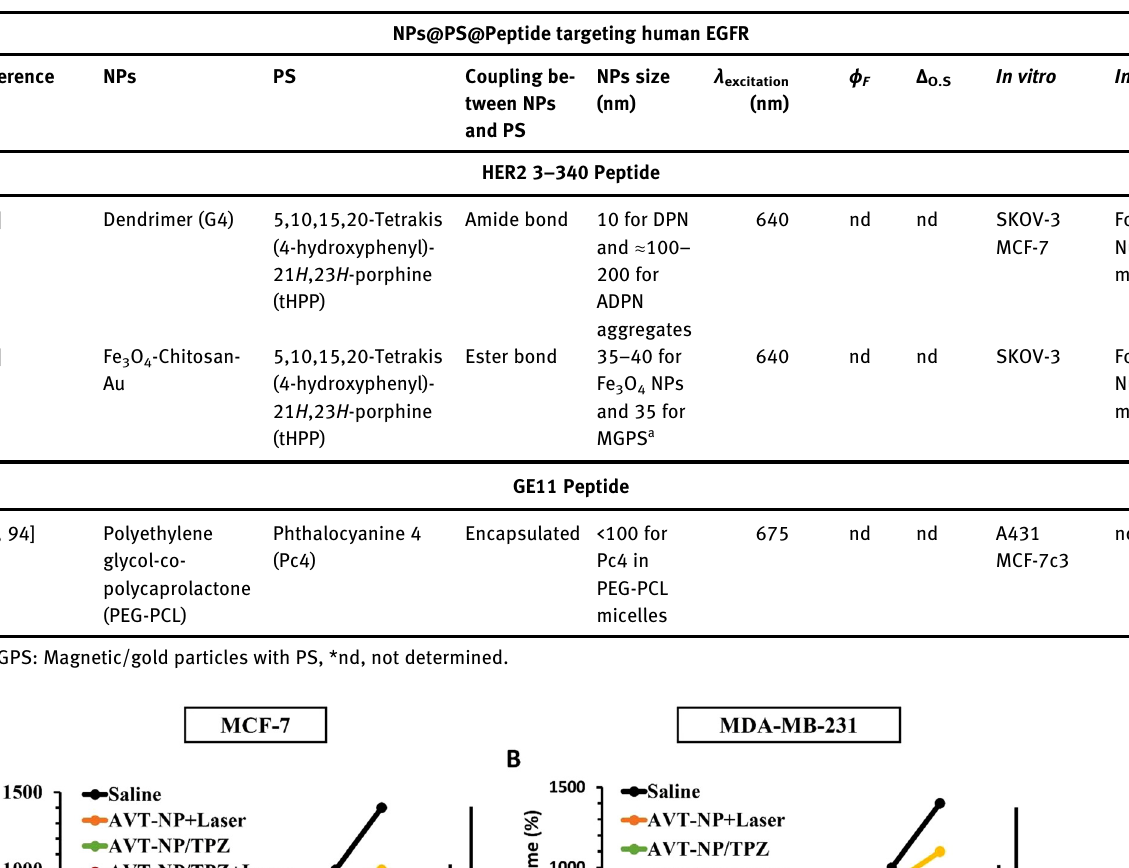
Table  : The summary of NPs conjugated with PSs and human EGFR targeting peptides in terms of different parameters.